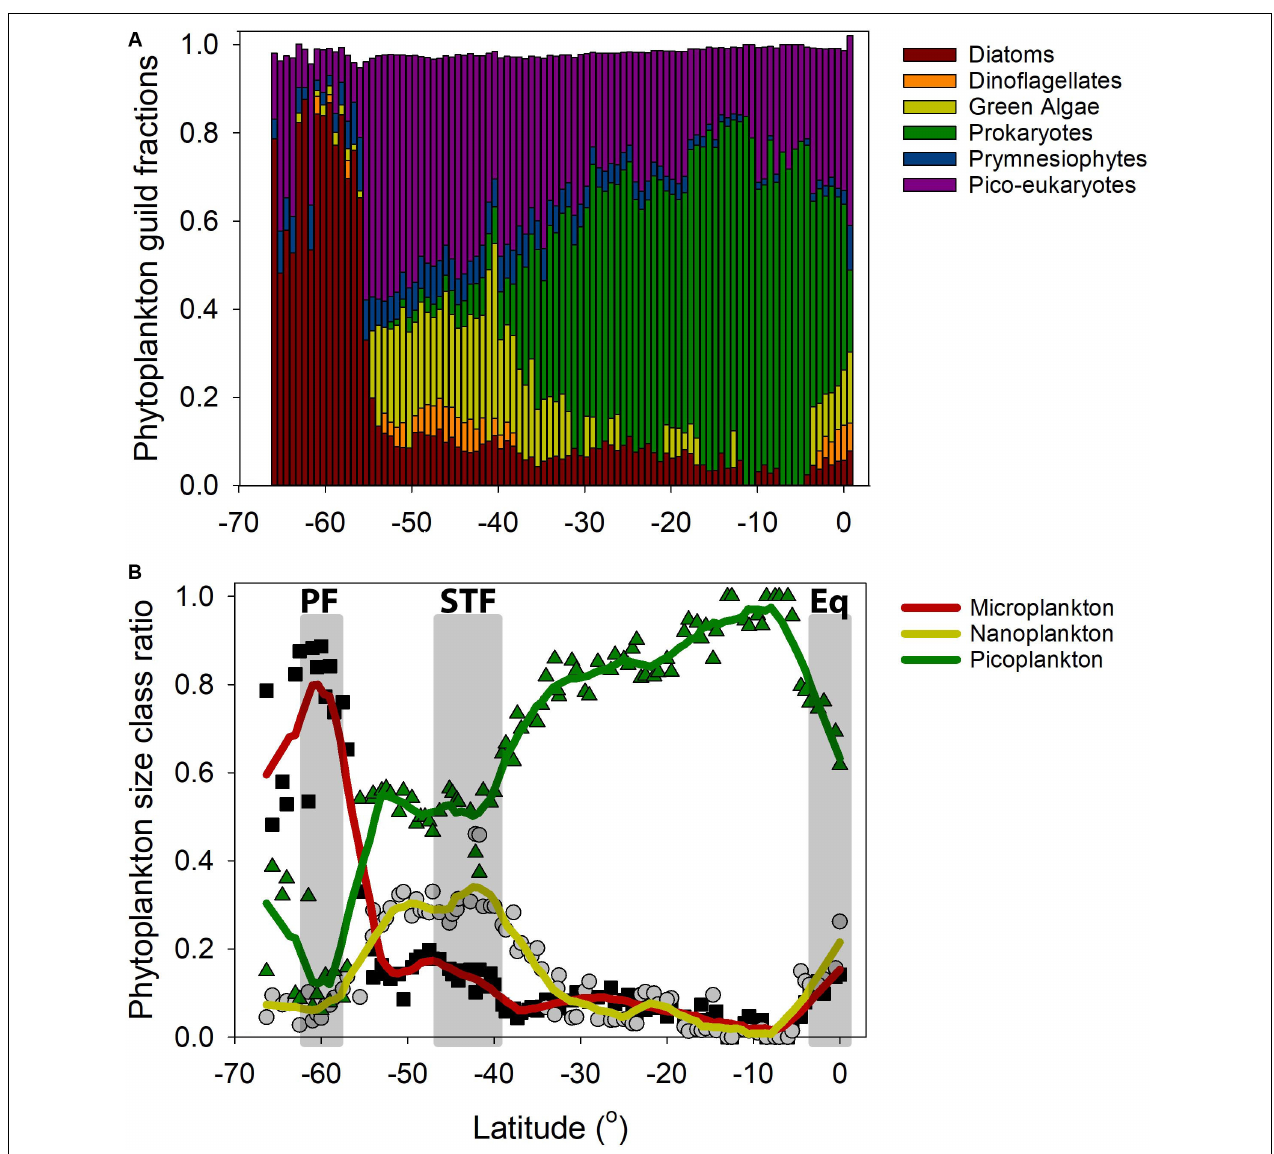
FIGURE 8 | Cumulative phytoplankton guild fractions based on Hirata et al. (2011), in the surface waters of the South Pacific Ocean. Filled black squares, filled gray circles, and green triangles picoplankton. Thick red, mustard, and green lines are first order polynomial smoothing lines. (A) Note (1) the abrupt decline of diatoms at 55 ◦ S, (2) the relative higher number of dinoflagellates near the STF and equatorial upwelling zone, and (3) the ubiquitous occurrence of both prymnesiophytes and pico-eukaryotes. (B) Phytoplankton size class distribution calculated according to Hirata et al. (2011) along the P15S GO-SHIP transect. The calculated size classes were microplankton (20 – 200 µ m), nanoplankton (2 – 20 µ m) and picoplankton (0.2 – 2 µ m) (Sieburth et al.,